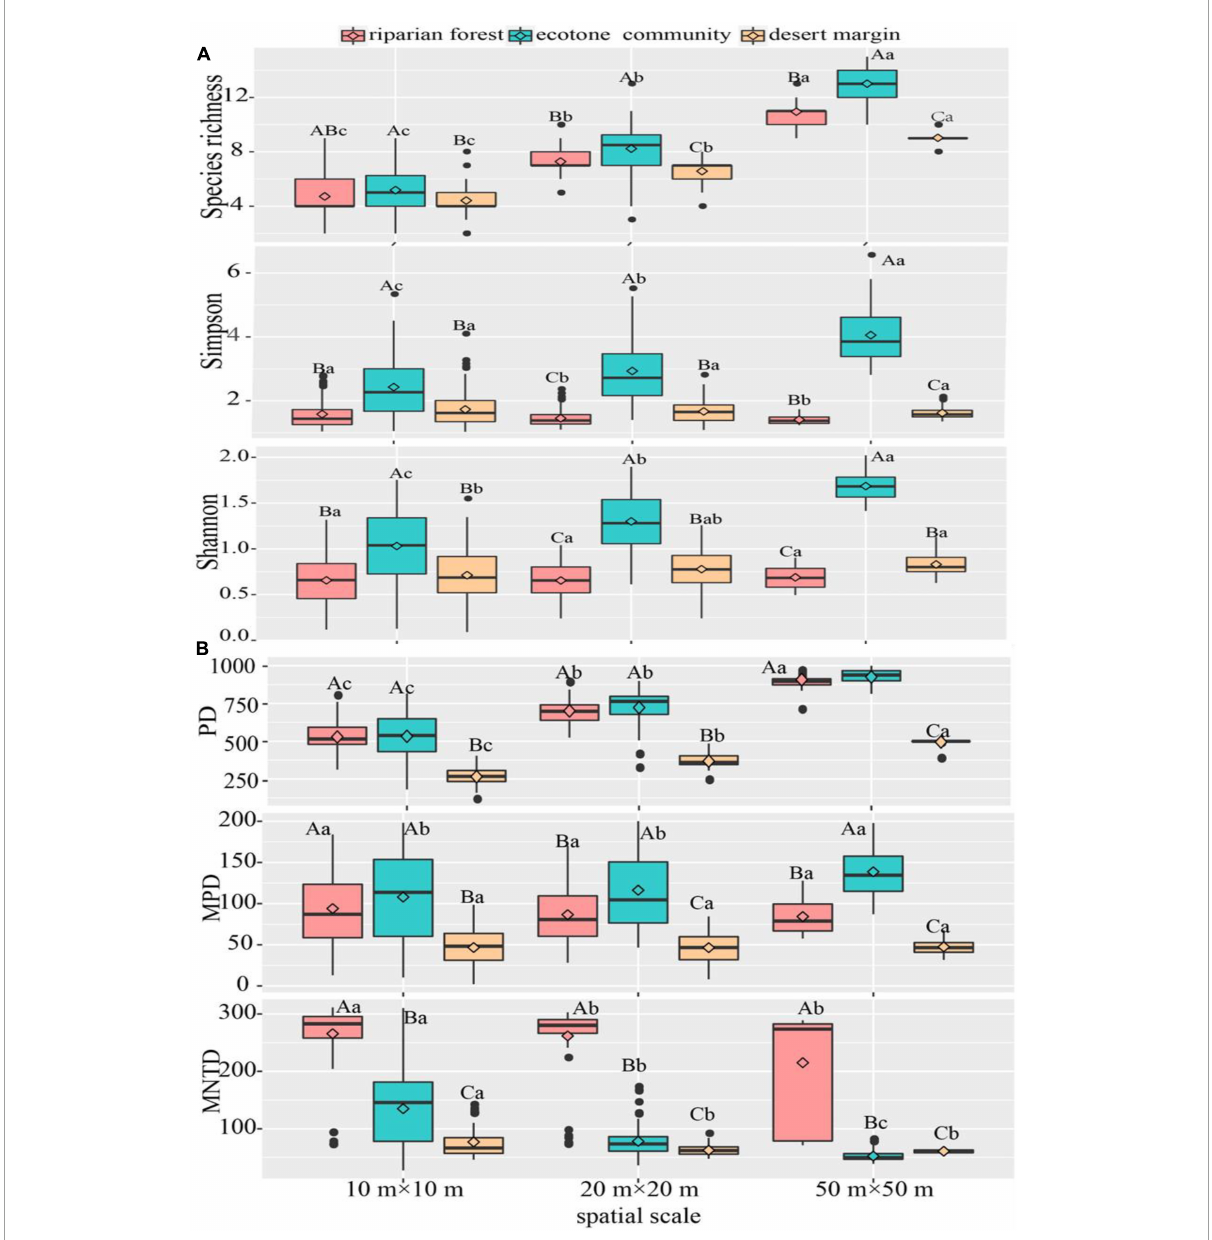
FIGURE3 Variation of species and phylogenetic diversities across spatial scales. (A) Species diversity; (B) phylogenetic diversity. The instruction of capital and lower-case letters see Figure 2 . P <